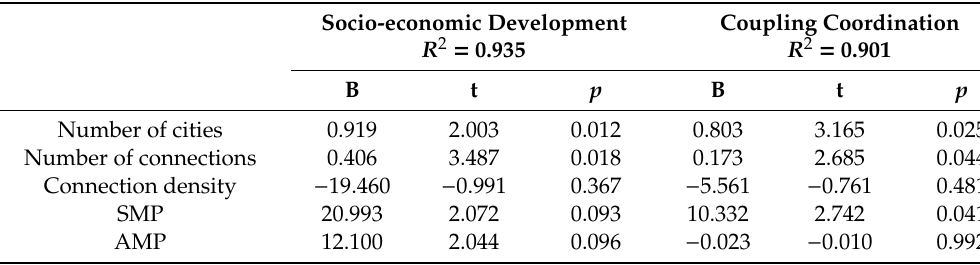
Table 8. The OLS regression results at the UA